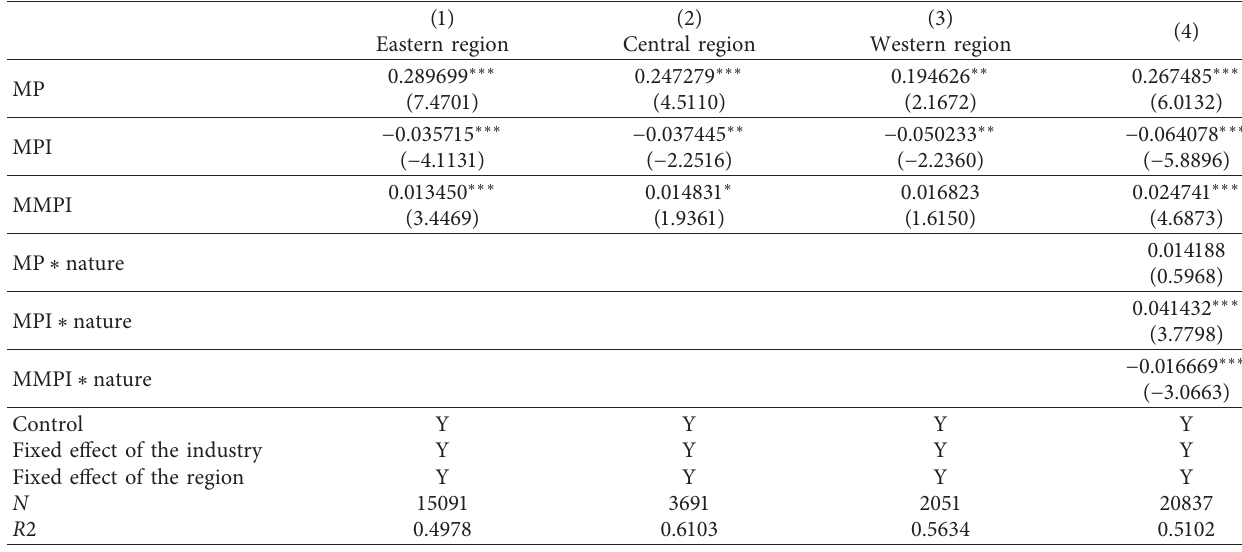
Table 4: Heterogeneity test.